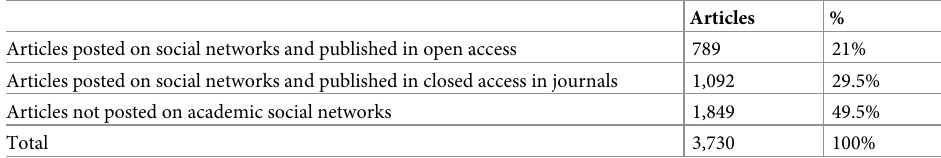
Table 11. Articles on academic social networks.